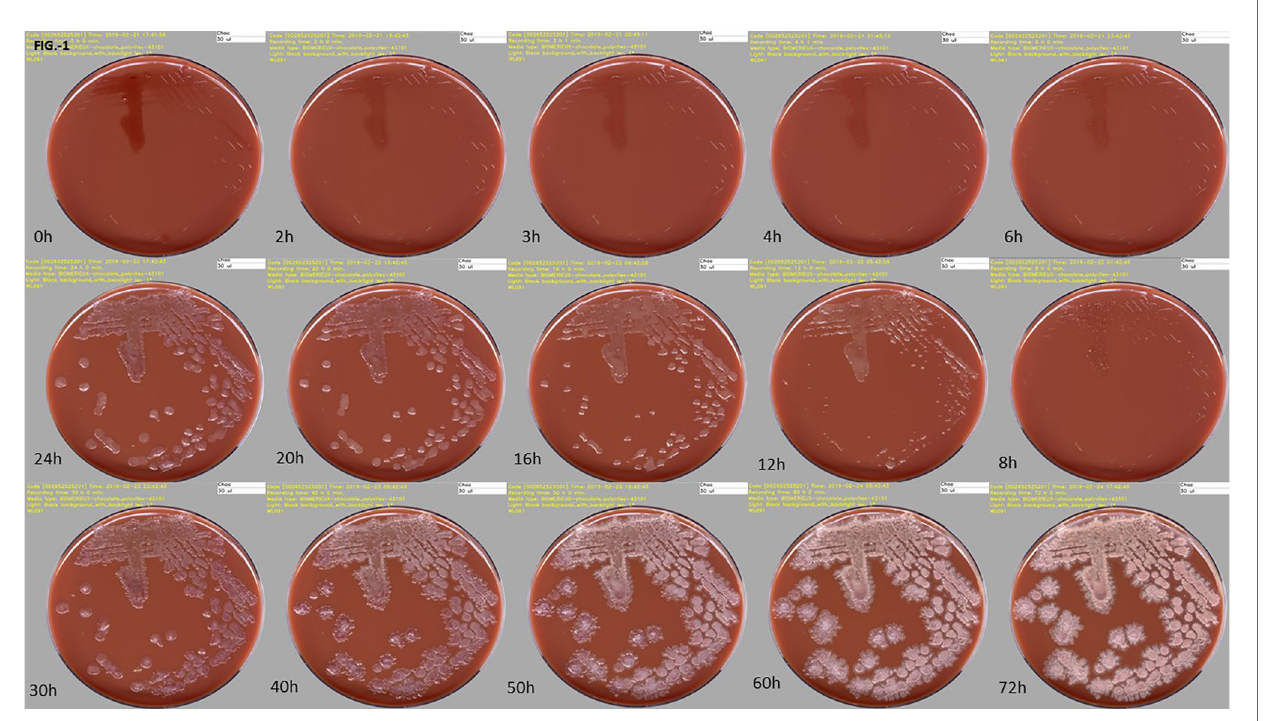
FIGURE 1 | High-resolution digital images of one culture media plate taken at different incubation times on the WASPLab ™ . Time-series image acquisitions for a clinical specimen positive with Bacillus sp., at ascending time points, is depicted here, highlighting the progressive growth of bacterial colonies. Source of all